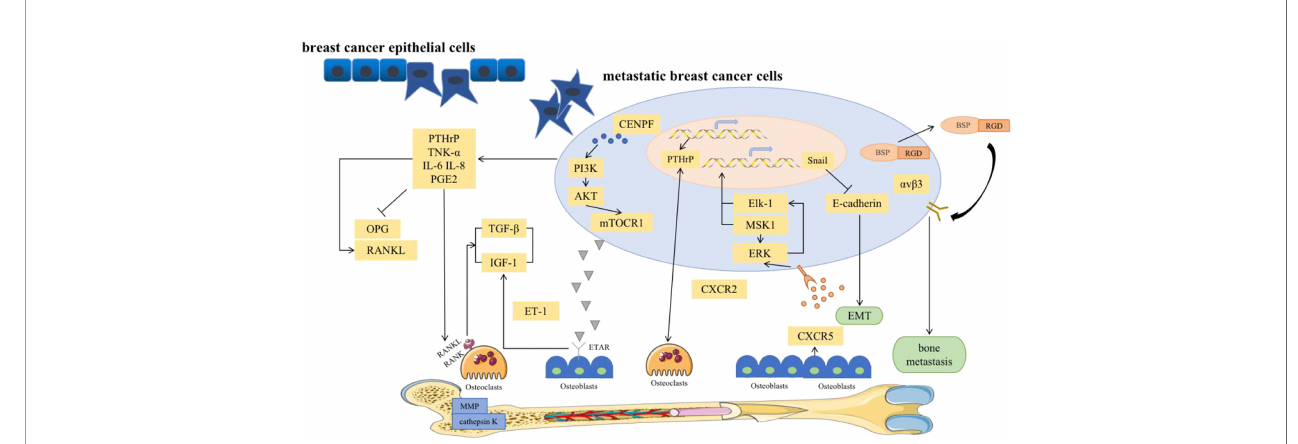
FIGURE 2 | Major signal pathways for bone metastases in breast